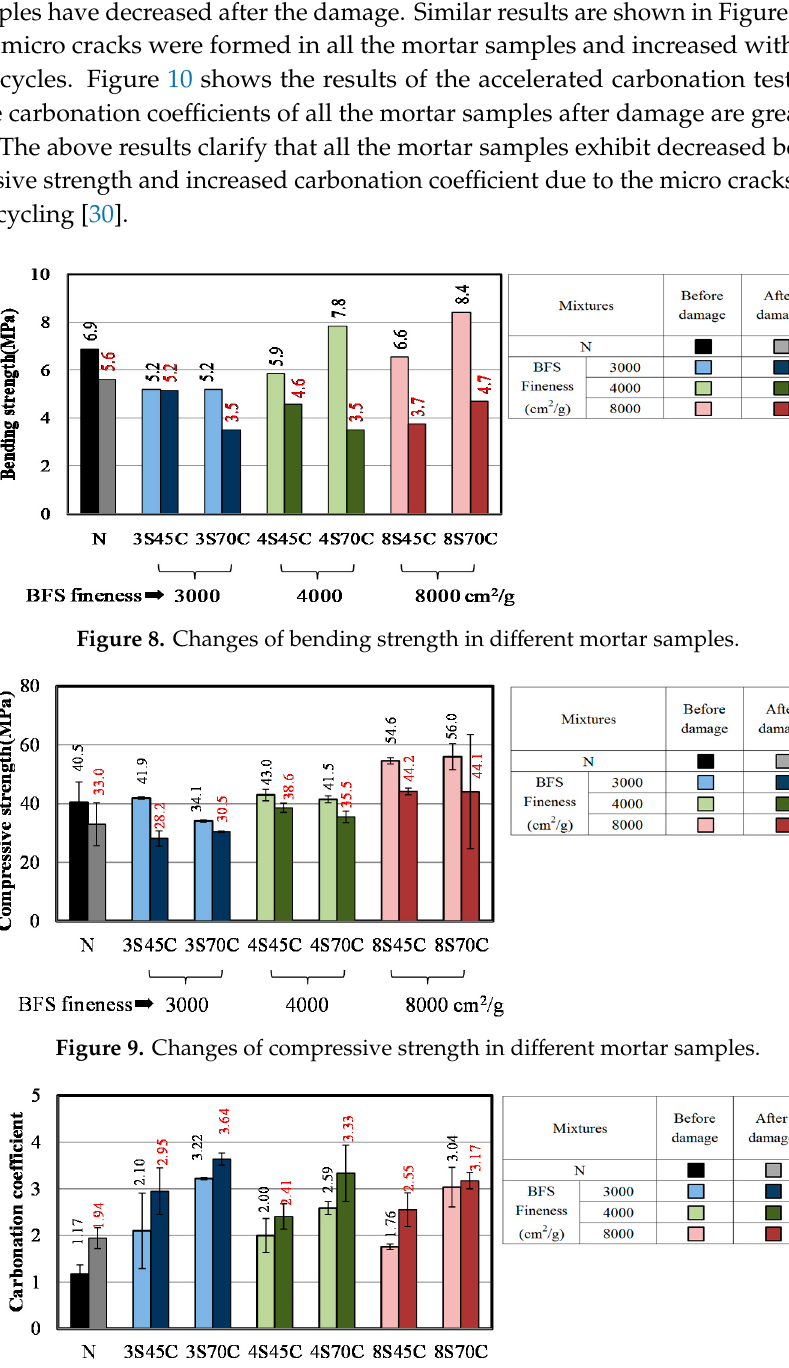
Figure 7. Results for the relative dynamic modulus of elasticity of the different mixtures after damage.